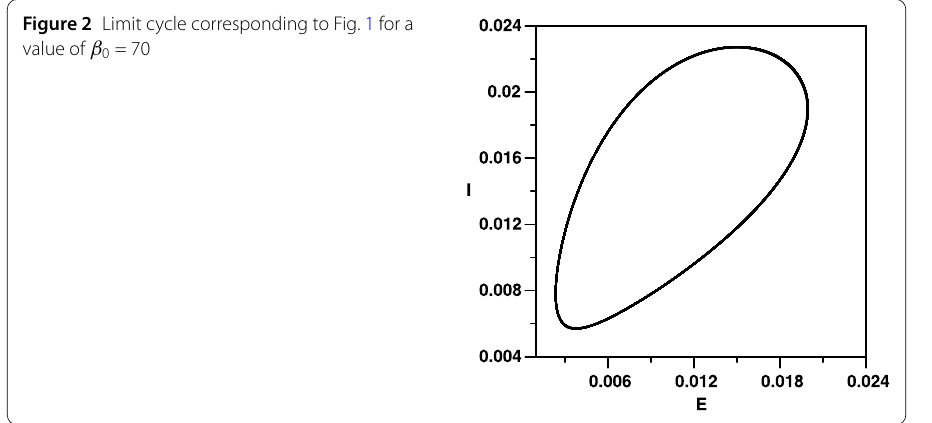
Figure 2 Limit cycle corresponding to Fig. 1 for a value of β 0 = 70